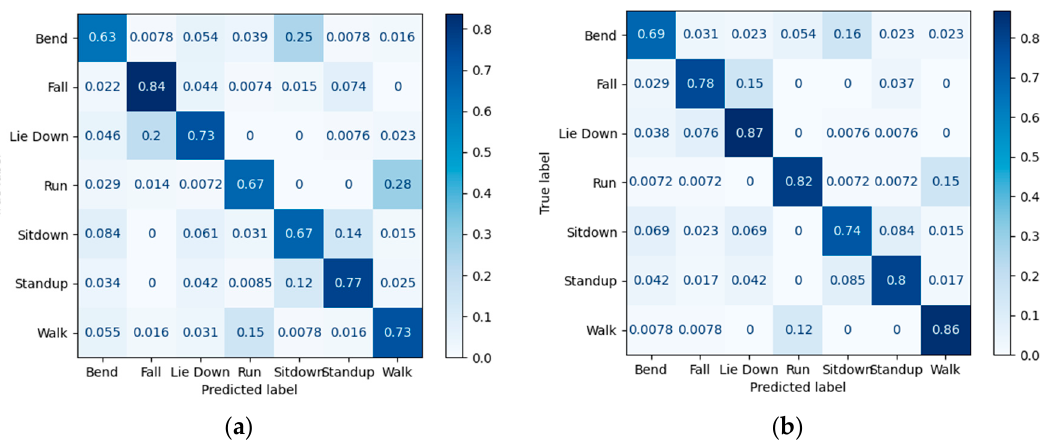
Figure 14. Confusion matrices of previous methods using 50% of the used data (including 80% of total data for training and validation data): ( a ) 2D-CNN [19]; ( b ) LSTM [19].